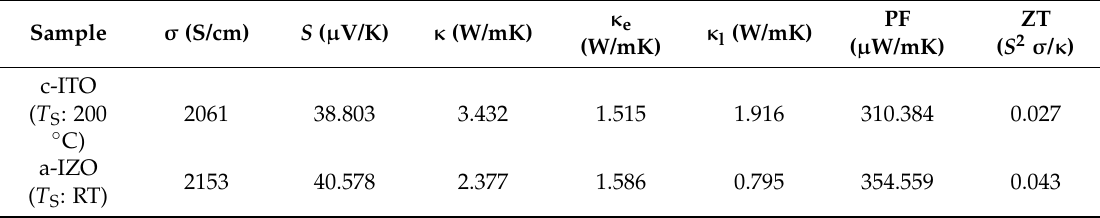
Table 1. σ , S , κ , κ e , κ l , PF, and ZT values for the c-ITO ( T S = 200 ◦ C) and a-IZO ( T S = RT) films. The a-IZO film shows twice higher ZT values compared to c − ITO due to low κ l that comes from amorphous